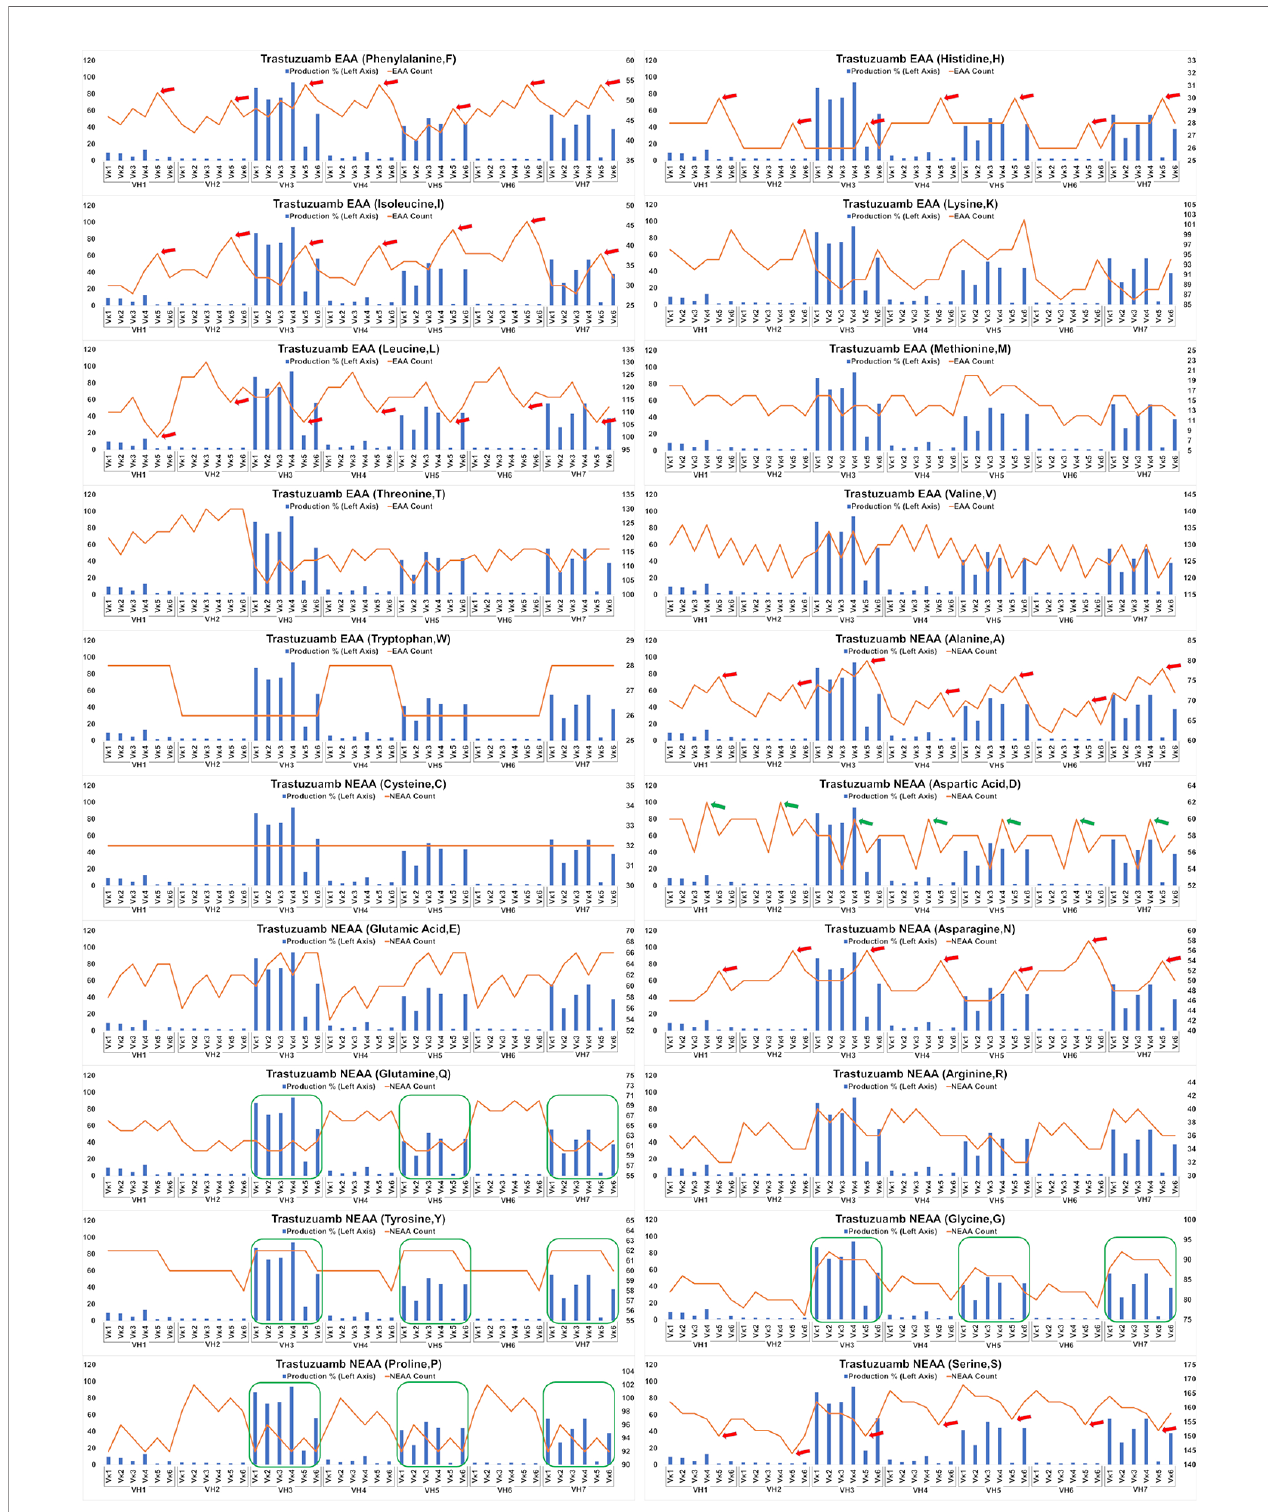
FIGURE 6 | Production in % (in bars, left axis) and amino acid counts (line, right axis) charts of recombinant Trastuzumab variants. The green arrows/boxes refer to an increase in production level while the red arrows depict a decrease in production